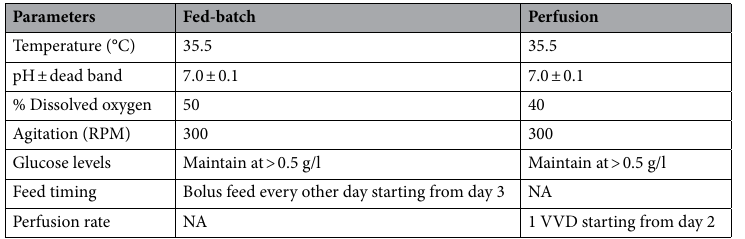
Table 1. Process parameters for fed-batch and perfusion processes. The same clonal CHO cell line expressing a BisAb was cultured using either a fed-batch or a perfusion process. The processes were run in duplicate 3 l bioreactors. Cells were inoculated at 0.8 × 10 6